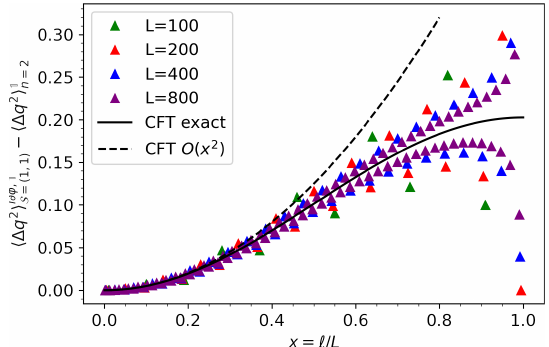
Figure 4 . Excess of variance associated to the partition S = (1 , 1) of the operators (Υ , χ ) = ( i∂φ, 1 ) . The universal CFT results are compared to the XX chain at half-filling. The numerical data for different sizes ( L = 100 , 200 , 400 , 800 ) are compared with both the full CFT result (solid line) and the small x expansion at order O ( x 2 ) (dashed